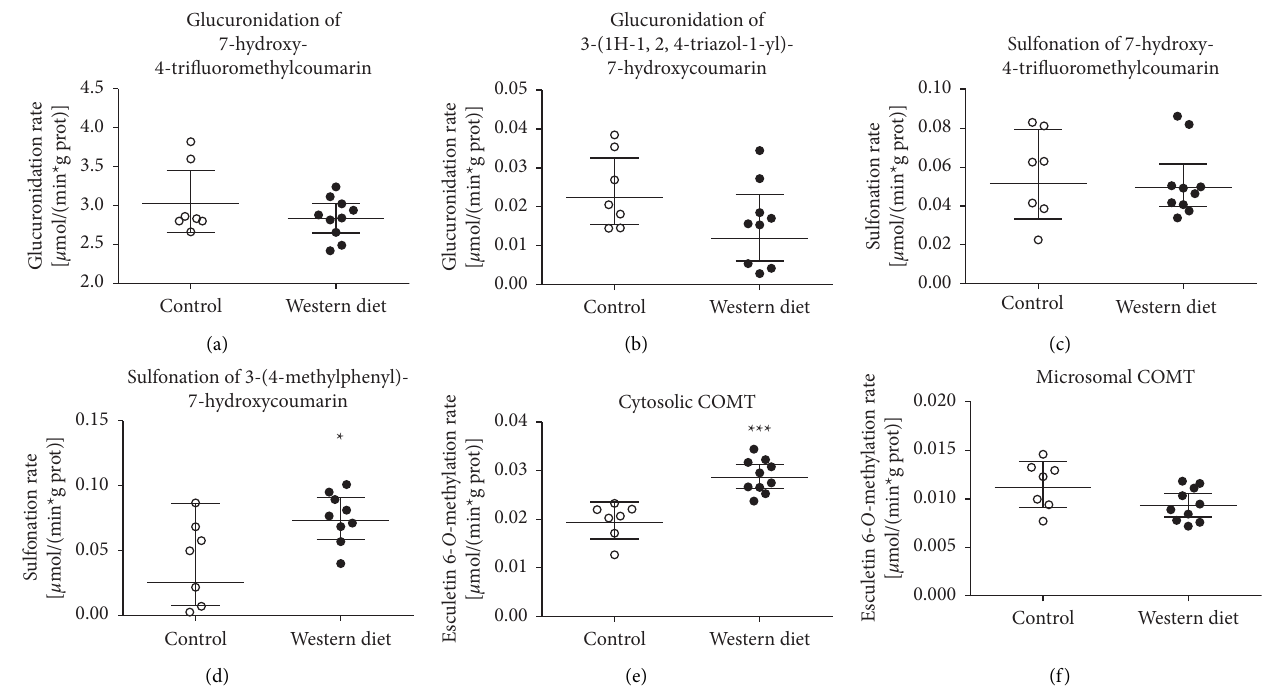
Figure 3: Te efect of the Western diet (WD) on the probe activities of conjugation enzymes in the liver cytosol or microsomes of male LDLr − / − ApoB 100/100 mice. Te liver microsome or cytosol samples were prepared from livers of eight months old mice; the animals were fed either with the WD or the chow diet for fve months. Glucuronidation, sulfonation, and catechol (O)-methylation (COMT) activities determined with the indicated probe substrates. ∗ , p < 0.05 ∗∗∗ , p < 0 . 001 WD vs. chow diet. Te lines of the groups represent geometrical means with 95% confdence interval: (a) glucuronidation of 7-hydroxy-4-trifuoromethylcoumarin, (b) glucuronidation of 3-(1H-1,2,4- triazol-1-yl)7-hydroxycoumarin, (c) sulfonation of 7-hydorxy-4-trifuoromethylcoumarin. (d) sulfonation of 3-(4-methylphenyl)-7- hydroxycoumarin, (e) cytosolic COMT, and (f) Microsomal